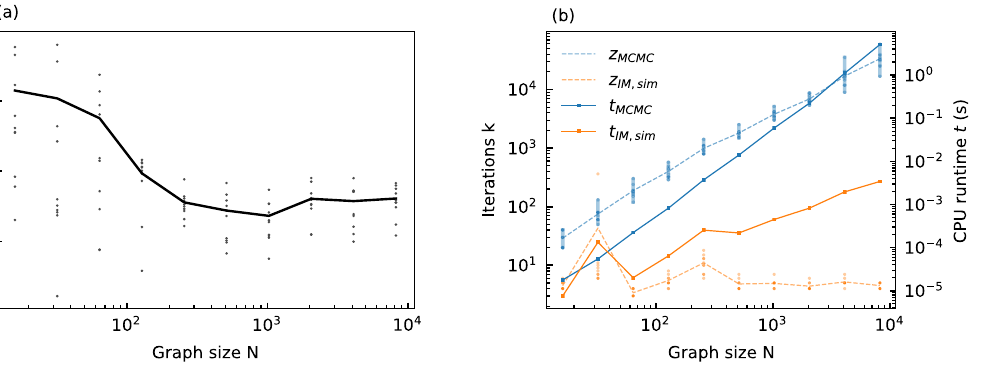
Fig.7|Scalabilityofsamplingaccuracyandspeedfortime-multiplexedanalog Ising machines. a Kullback – Leibler divergence as a function of the problem size for sampling the energy distributions for the different random sparse graphs in Fig.4a(dots)usingsimulationsofthetime-discretemodelineq.(9).Thesolidline shows the average. b Number of iterations z required to create statistically